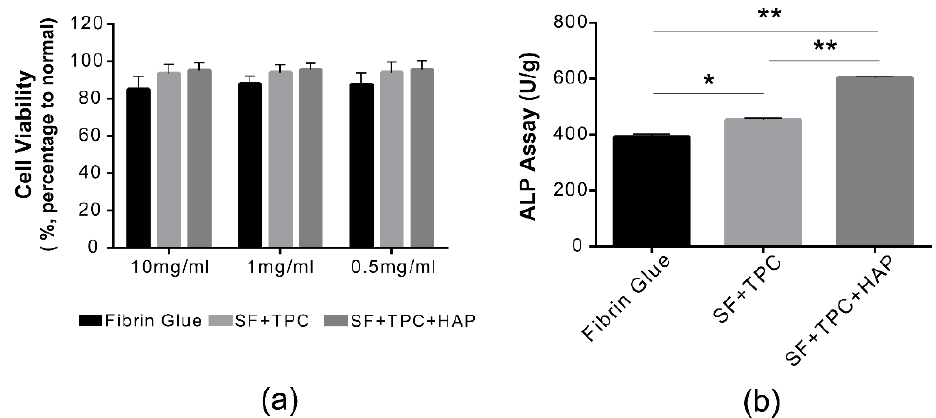
Figure 4. Functional analysis. ( a ) Cell viabilities were measured in both undiluted (10 mg/mL) and diluted states (1 mg/mL and 0.5 mg/mL) of both fibrin and silk fibroin proteins. There was no difference in cell viability among conventional fibrin glue, silk fibroin protein in skin (SF + TPC), or silk fibroin protein in bone (SF + TPC + HAP). There was no cytotoxicity at 10 mg/mL. ( b ) ALP activity was presented as U/g in each group of fibrin, SF + TPC, and SF + TPC + HAP. SF, silk fibroin; TPC, tannic acid, and polyethylene glycol 2000 as curing agents; HAP, hydroxyapatite. n = 5, * p < 0.05; ** p <